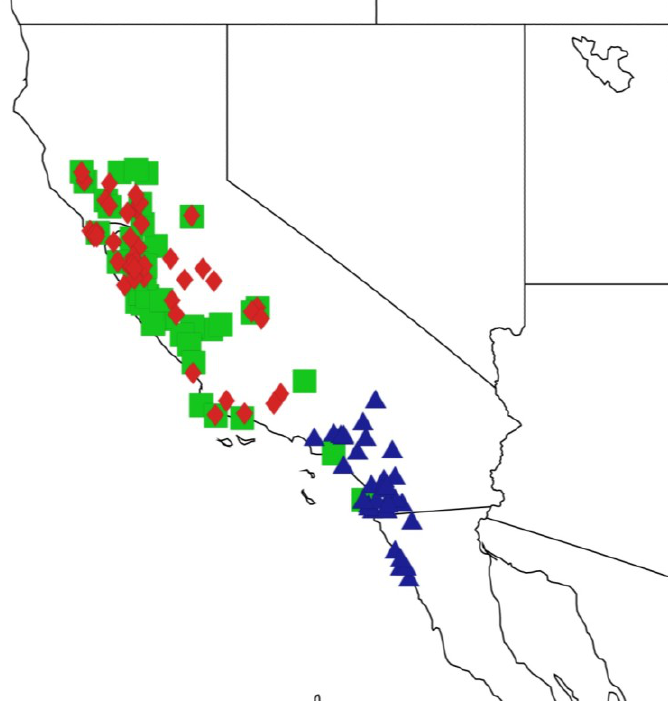
Figure 65. Distribution of Tibicinoides minuta (green squares), T. mercedita (red diamonds) and T. cupreosparsus (blue